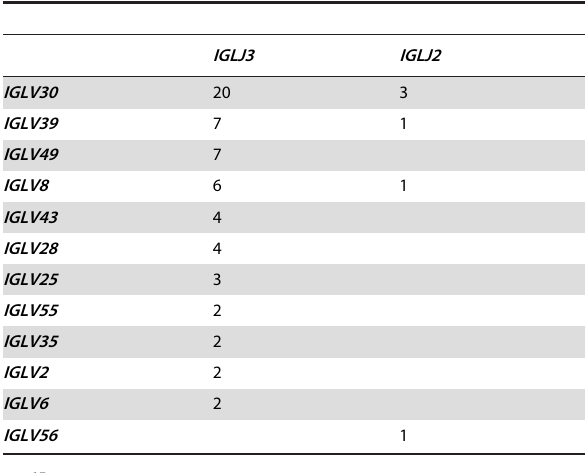
Table 3. Expressed combinations of IGLV and IGLJ gene segments in bovine fetal bone marrow and ileum.